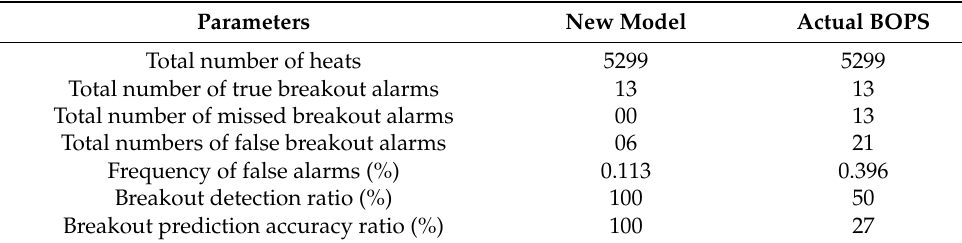
Table 4. Prediction results new and actual breakout prediction system (BOPS).